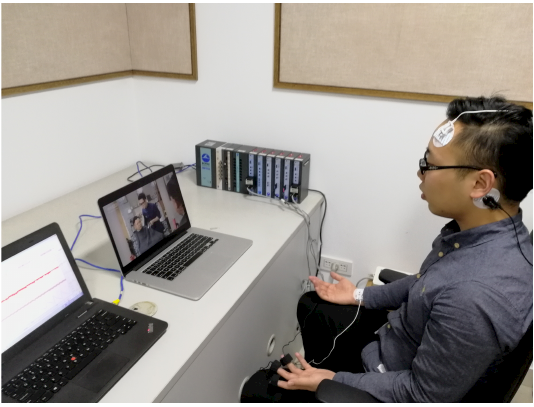
Figure 6. A participant in emotion induction